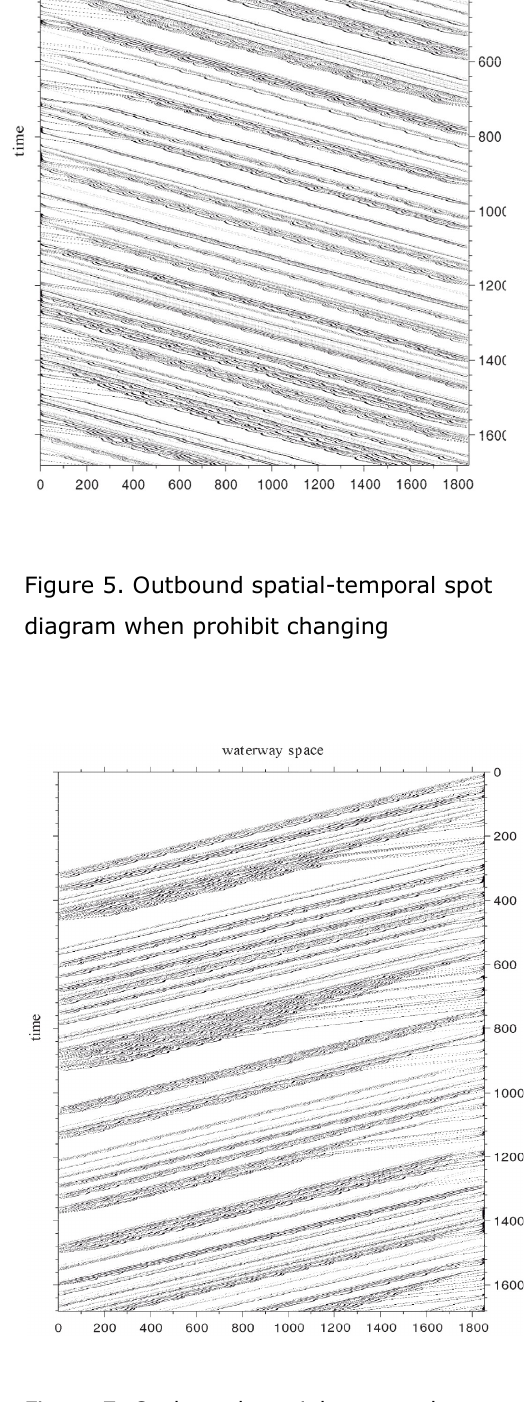
Figure 6. Outbound spatial-temporal spot diagram when allow changing